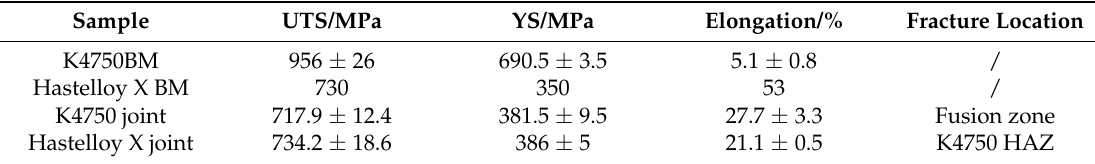
Table 5. Tensile properties of base metals and dissimilar joints with varies filler materials.